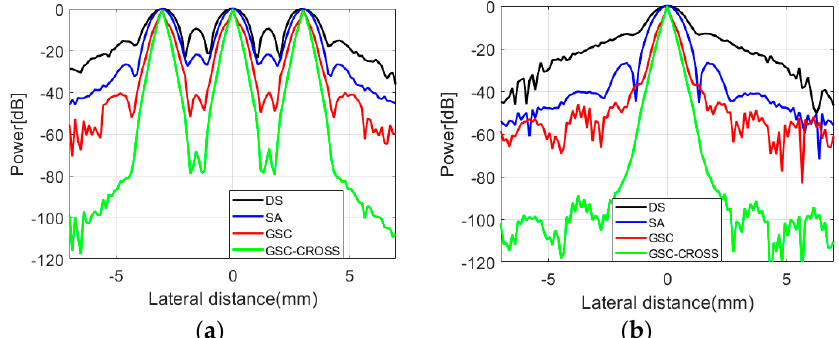
Figure 4. Lateral variation of point at ( a ) z = 35 mm; ( b ) z = 40 mm.